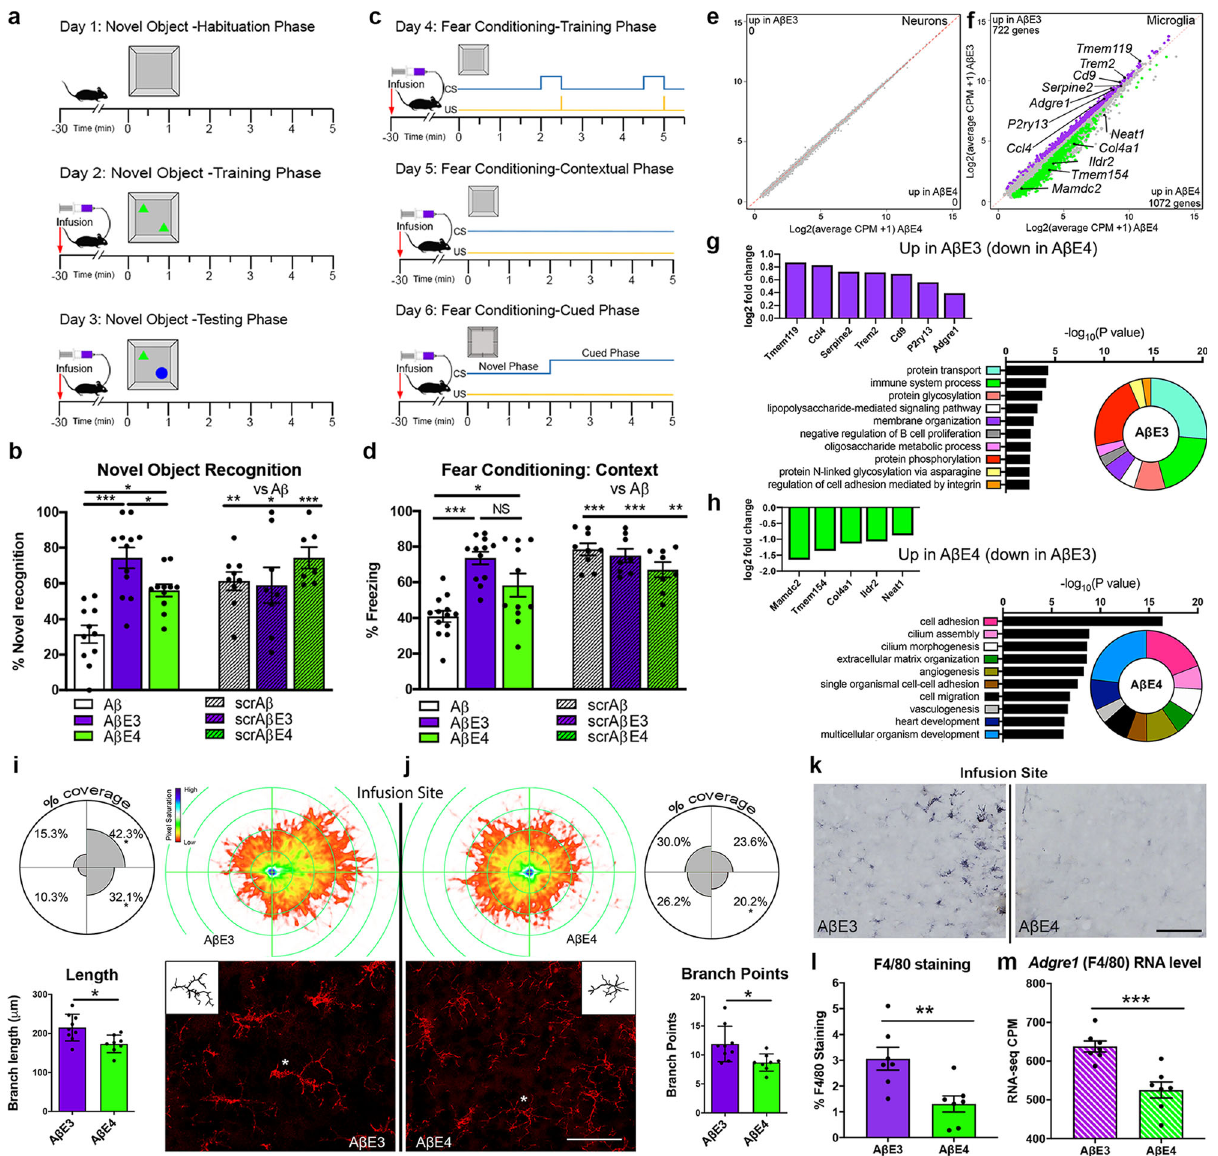
Fig. 2 Effect of native E3 and E4 lipoproteins on A β induced cognitive decline and microglial response. a – d A β preparations after 24 h incubation (A β , white; A β E3, purple; and A β E4, green) were infused into the brain of 2-month-old WT mice and cognitive performance examined by novel object recognition ( a , b ) and fear conditioning ( c , d ). Scrambled A β (scrA β ) was used as negative control (scrA β + Veh, scrA β E3, and scrA β E4; line pattern). All mice were infused 30 min prior to training on days 2 through 6 of behavioral testing as shown on a and c . Analysis by one-way ANOVA followed by Tukeys multiple comparison test. A β vs. A β E3, p < 0.0001; A β vs. A β E4, p = 0.0044; A β E3 vs. A β E4, p = 0.0351; A β vs. scrA β , p = 0.0088; A β vs. scrA β E3, p = 0.0251; A β vs. scrA β E4, p = 0.0002 for novel object recognition. A β vs. A β E3, p < 0.0001; A β vs. A β E4, p = 0.0388; A β vs. scrA β , p < 0.0001; A β vs. scrA β E3, p < 0.0001; A β vs. scrA β E4, p = 0.0015 for fear conditioning. n = 12 for A β ± E3 or E4, and n = 8 for scrA β controls. The same A β preparations were infused into the cortex of another group of WT mice and 24 h later microglia and neurons from one cortex were sorted via MACS and used for RNA- seq. n = 5 mice per group. e , f Scatterplots of neuronal ( e ) and microglial ( f ) gene expression pro fi le from A β E3 vs. A β E4 injected. Genes signi fi cantly upregulated at FDR <0.05 in A β E3 (purple), and A β E4 (green). g , h Bar plots of signi fi cantly upregulated genes and GO terms of A β E3 ( g , purple) and A β E4 ( h , green) groups. i , j IBA1 staining around the infusion site of the same A β E3 ( i , purple) or A β E4 ( j , green) groups. Imaris fi lament tracer was used for generation of a microglial projection heatmap around the infusion site. Bottom: representative images of IBA1 staining with Imaris tracing of the labeled (*) microglia as an inset. Scale bar = 50 µ m. n = 3 mice/group; 86 microglia/A β E3 and 106 microglia/A β E4. Bar graphs show increased branch length and points of microglia around the infusion site of the A β E3 (purple) vs. A β E4 (green) group. Analysis by two-tailed unpaired t -test; p = 0.0103 for branch length and p = 0.0173 for branch points. k – m Representative images of the F4/80 (Adgre1) immunostaining around the infusion site of A β E3 or A β E4 group ( k ). Images are positioned with the infusion site in the middle. Scale bar = 100 µ m. l Bar graph showing percent coverage of F4/80 staining increased around the infusion site of the A β E3 (purple) vs. A β E4 (green) group. p = 0.0069 ( m ) Bar graph showing mRNA level of Adgre1 as determined by RNA-seq (CPM, count per million, line pattern, p = 0.0007). Analysis by two-tailed unpaired t -test. n = 7 mice per group. Bars represent mean ± SEM. * p < 0.05, ** p < 0.01; *** p < 0.001; NS no signi fi cance.